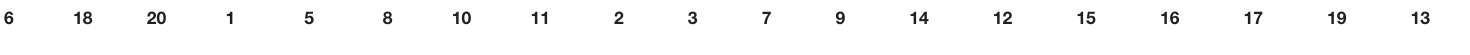
TABLE 3 | Correlation of the 20 items of the Chinese version of